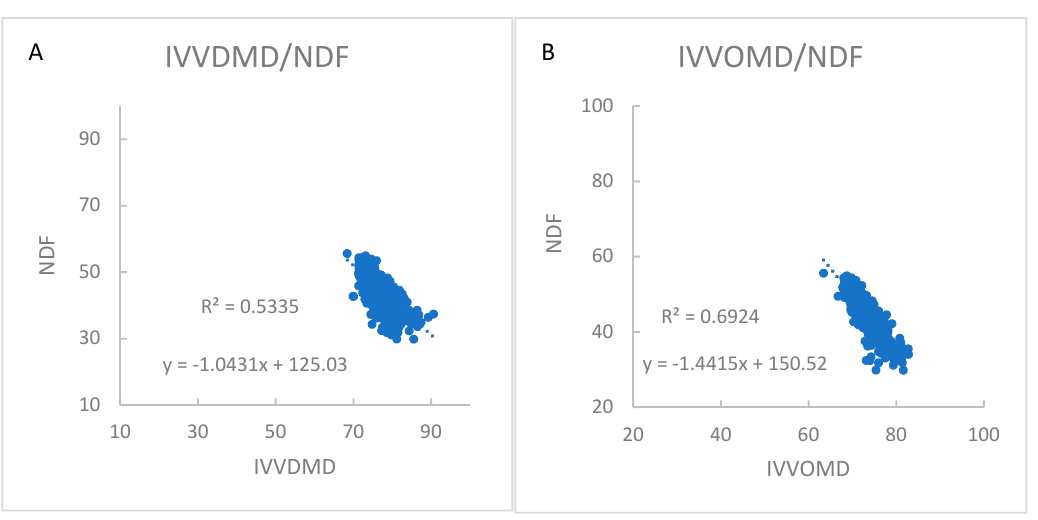
Figure 4. ( A ) Parameters IVVDMD and NDF showed R 2 of 0.5335 for correlation between model predicted results for 159 plants; ( B ) NDF and IVVOMD rankings showed R 2 of 0.6924 for the correlation between model predicted results for 159 plants.